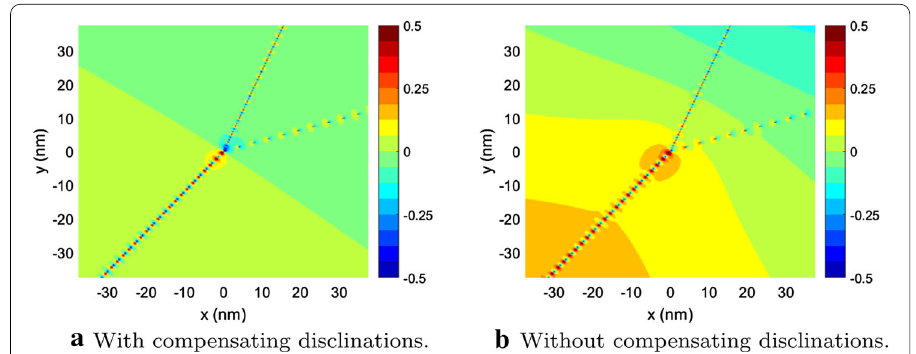
Fig. 7 Triple junction (with 25 ◦ , 75 ◦ , − 10 ◦ angles) constructed with and without compensating disclinations. Normalized hydrostatic stress σ kk /μ is shown